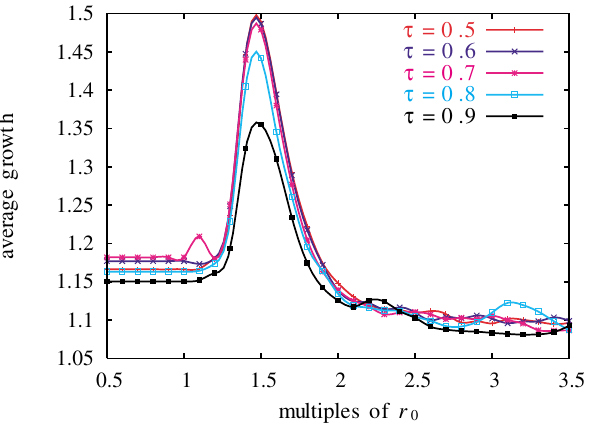
FIG. 6. (Color) Maximum amplitude growth for single par- ticles over 100 zero-current betatron periods as a function of their initial radius and tune depression (cid:18) . Each dot represents the averaged results of 1000 runs with different error sets for 1% rms error.